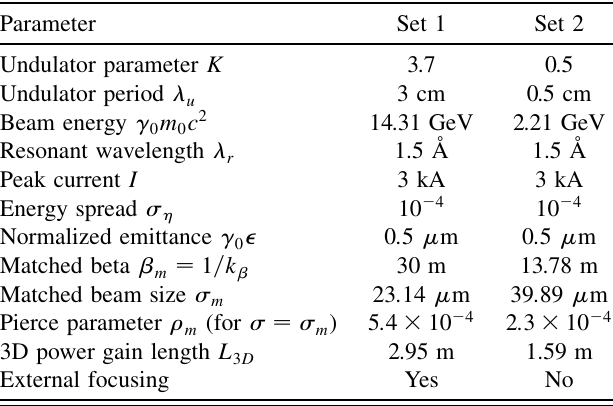
TABLE I. Undulator and electron beam